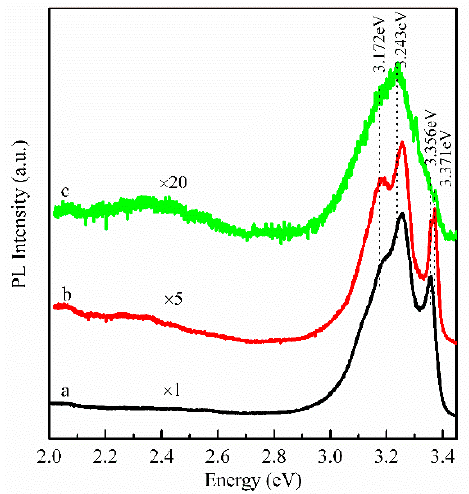
Figure 4. PL spectra of the samples (a) A, (b) B, and (c) C at 83 K.